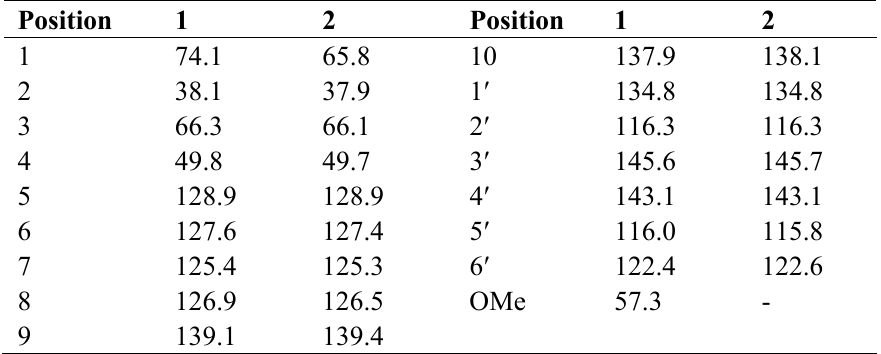
OD) spectroscopic data of 1 – 2 . 3